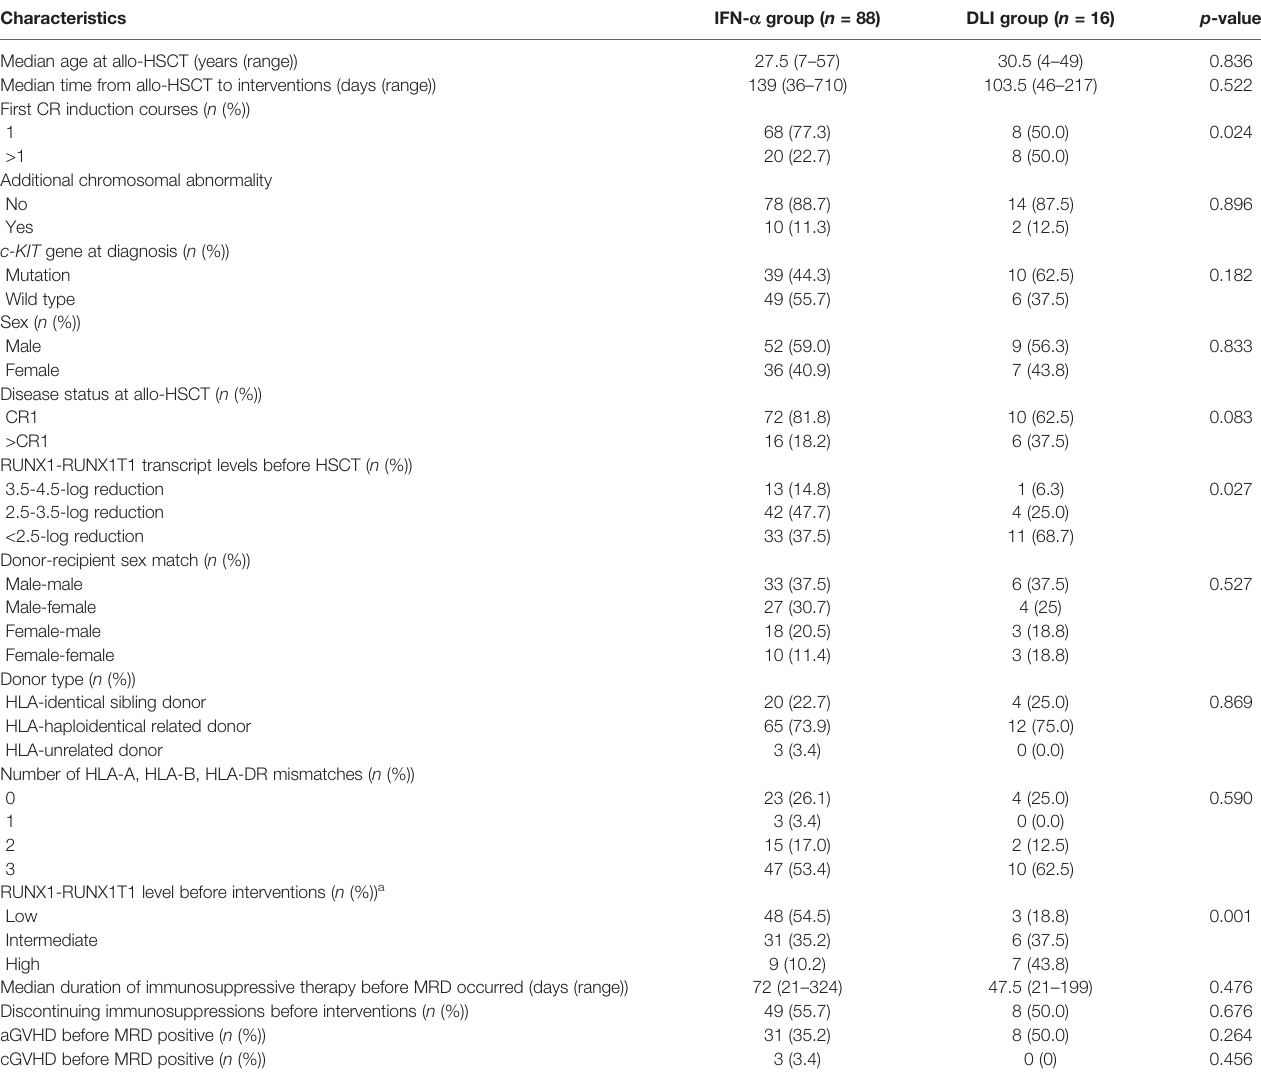
TABLE 1 | Patient